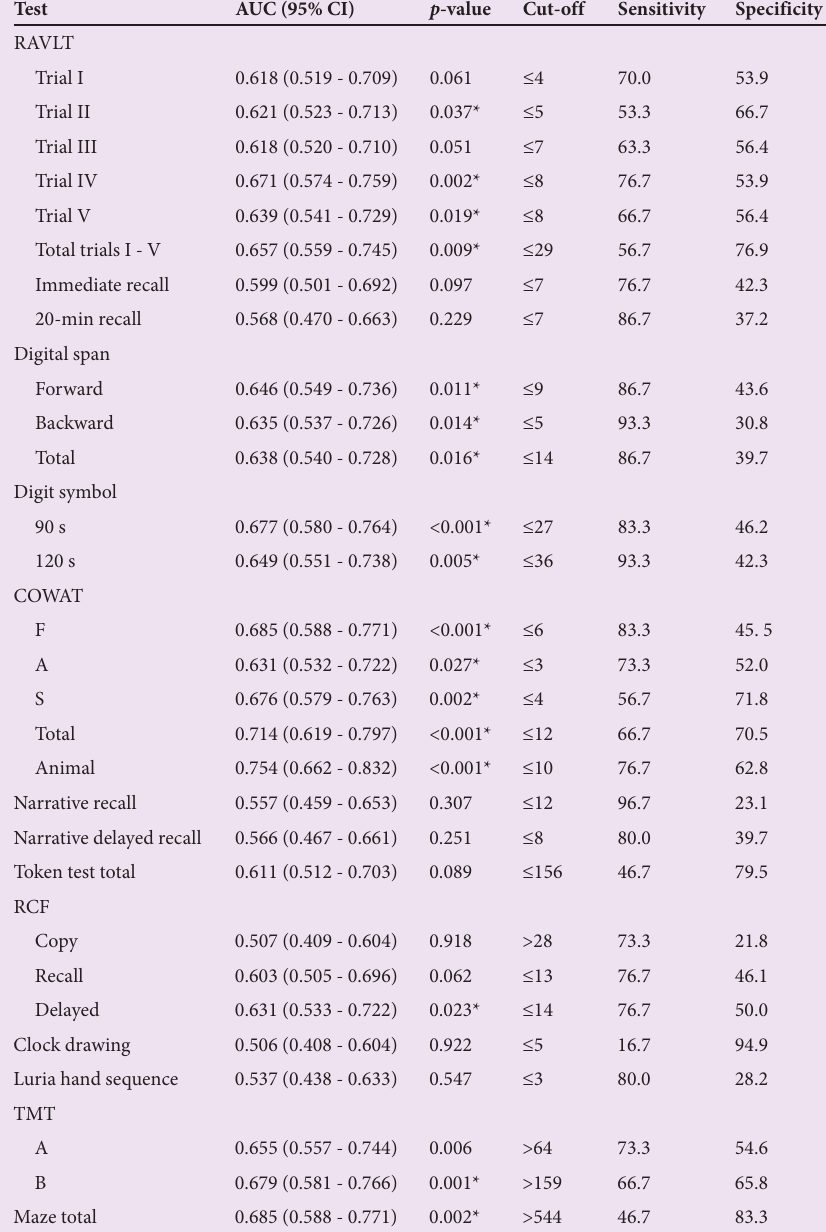
Table 4. ROC analysis tests for MCI v.